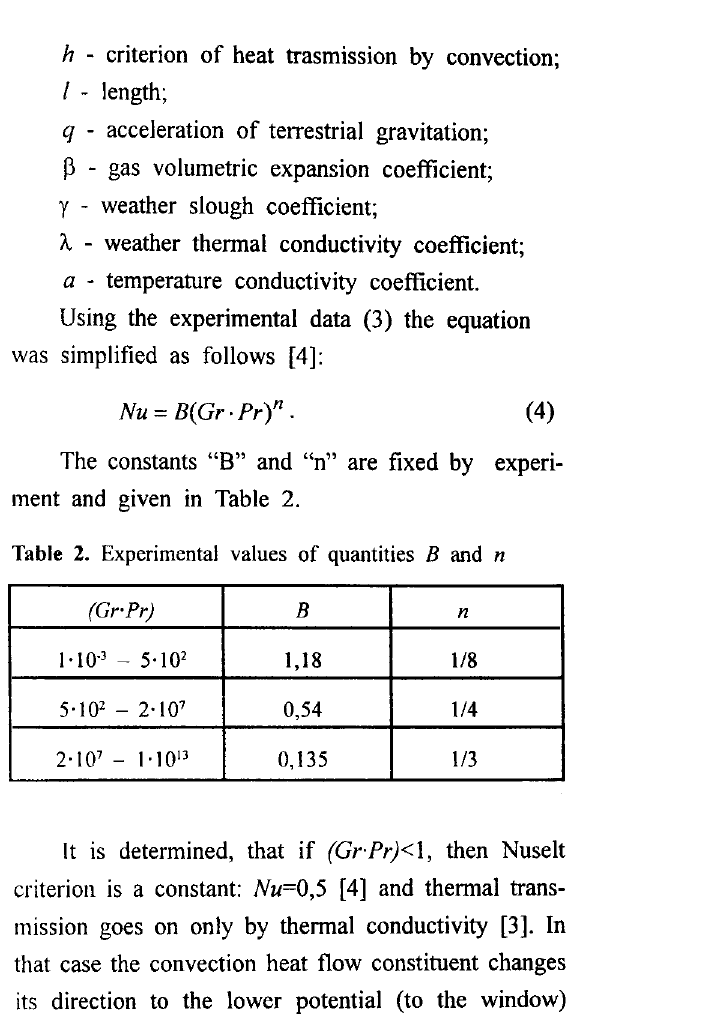
Table 2. Experimental values of quantities B and n